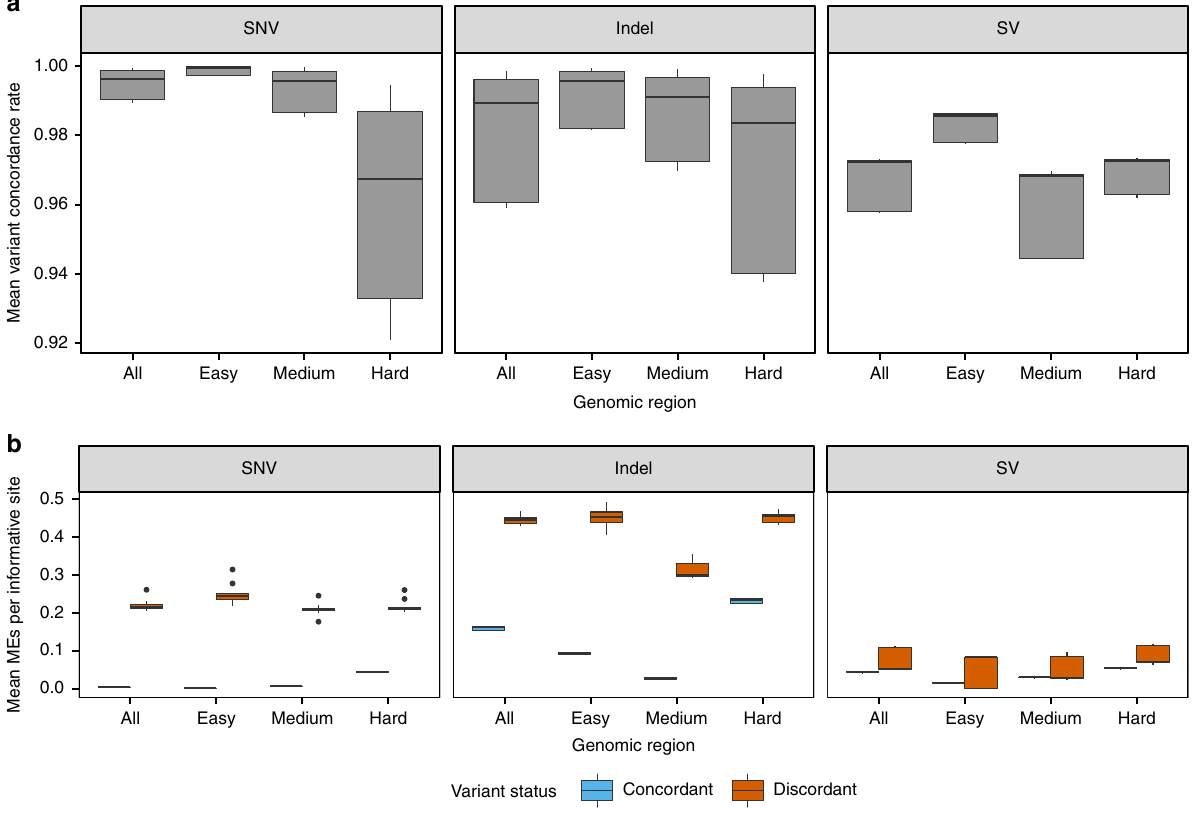
base quality recalibration table is generated using GATK BaseRecalibrator (v3.6) with knownSites fi les (dbSNP138, Mills and 1 kg indels, and known indels) from the GATK resource bundle (https://console.cloud.google.com/storage/browser/ genomics-public-data/resources/broad/hg38/v0) and parameters